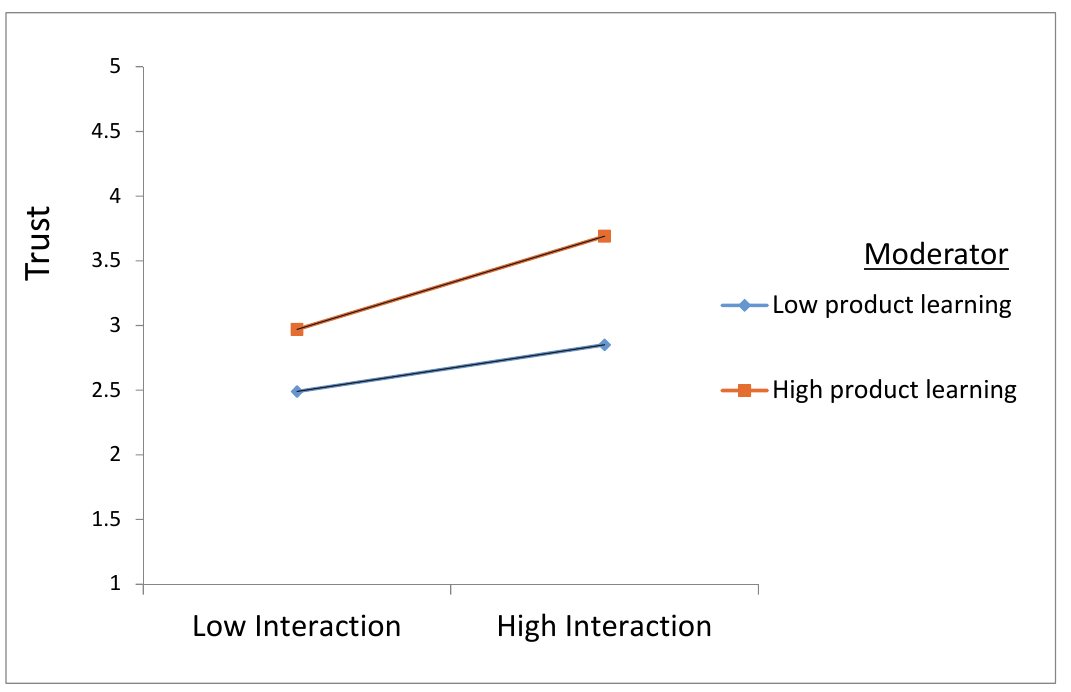
Fig. 4. Product learning moderating impact on the relationship between interaction and trust The interaction effect was found to be significant ( β = .18, p < .000), whereby the positive effect of product learning has a strengthening impact on the positive relationship between customer social media interaction and